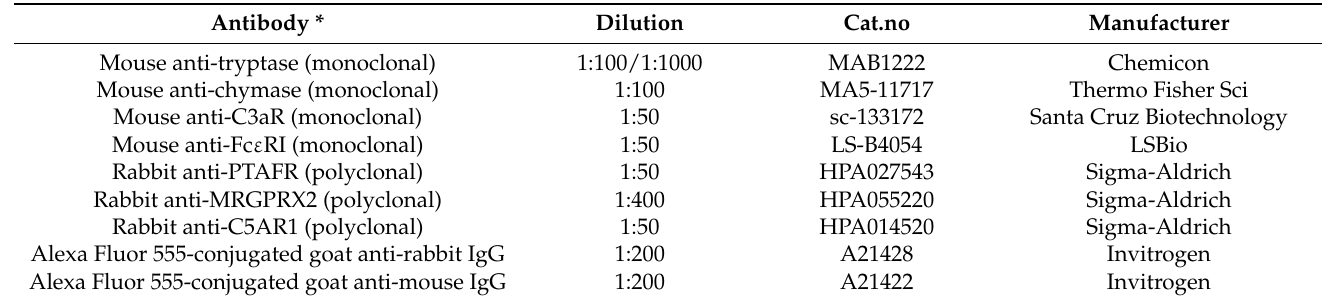
Table 1. Primary and secondary antibodies used for